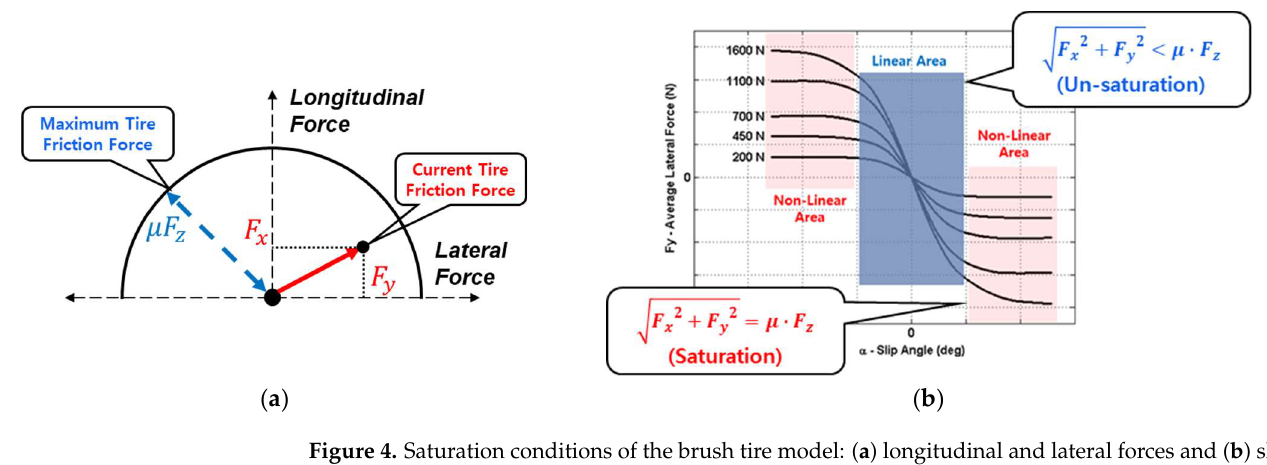
Figure 4. Saturation conditions of the brush tire model: ( a ) longitudinal and lateral forces and ( b ) slip VS tire force.